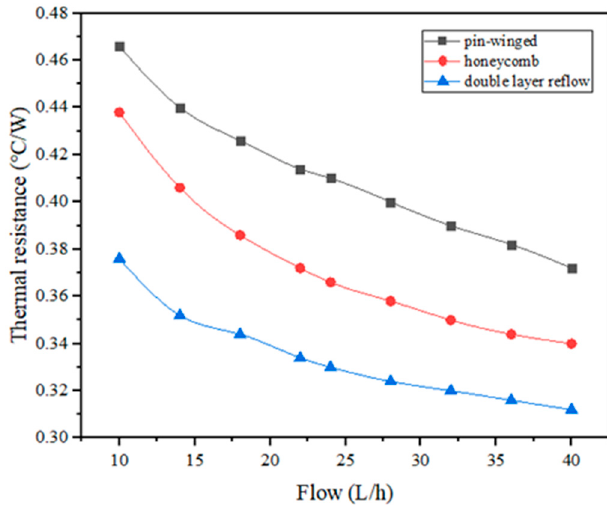
Figure 6. Curve of thermal resistance versus coolant flow.